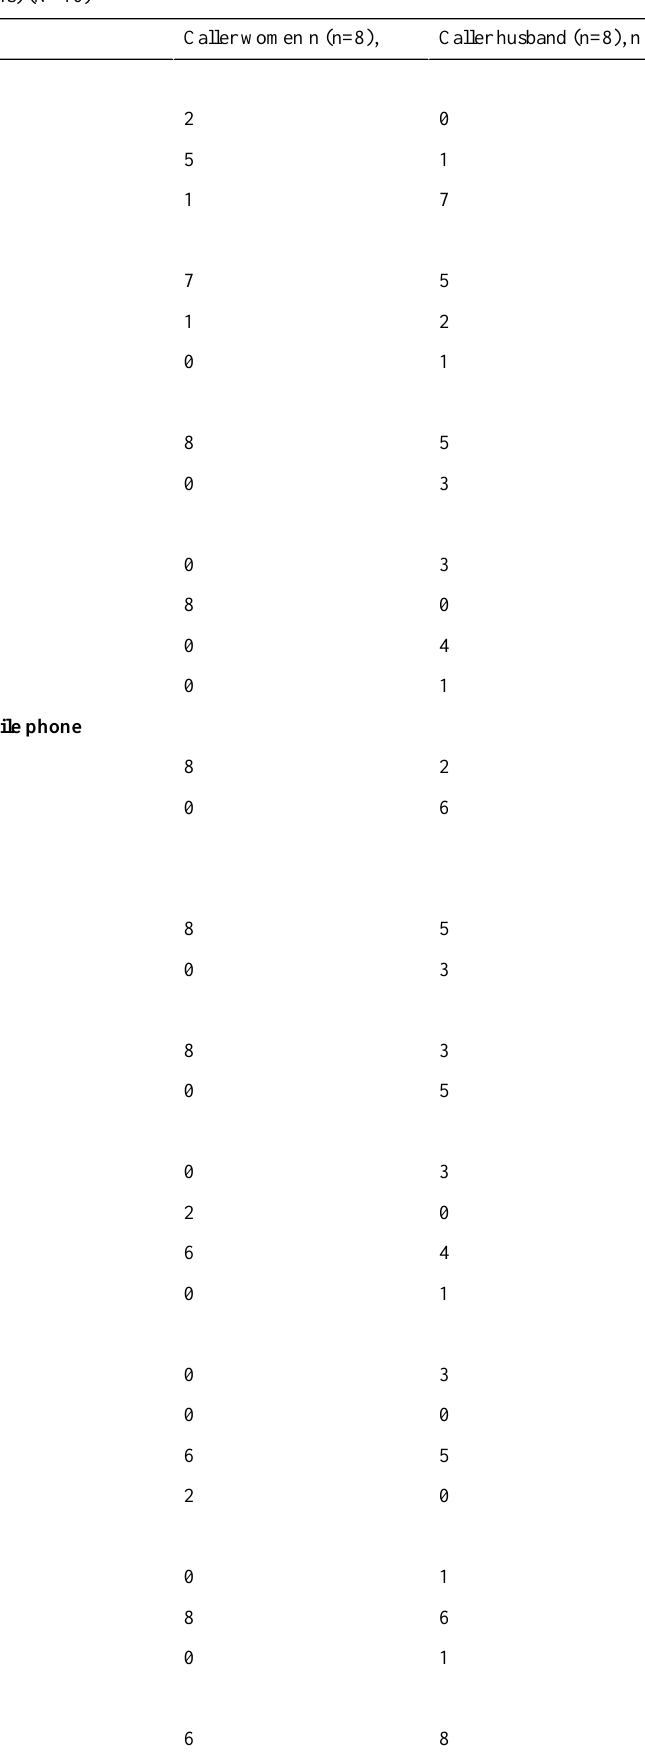
Table 4. Background information of participants (Aponjon subscribers)